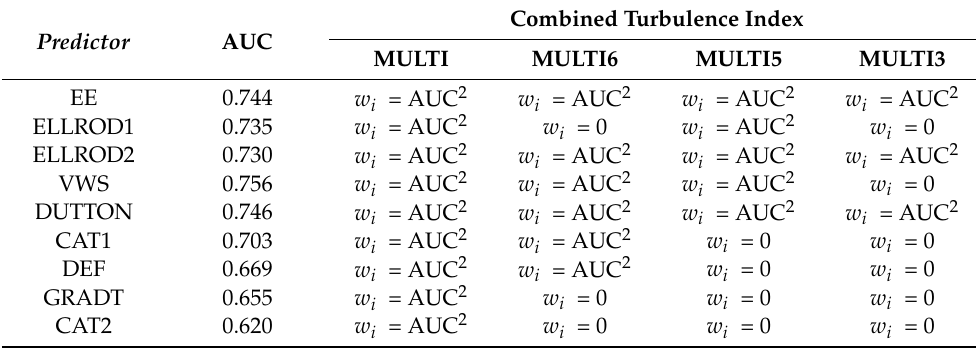
Table 4. Combined turbulence indices and their weighting